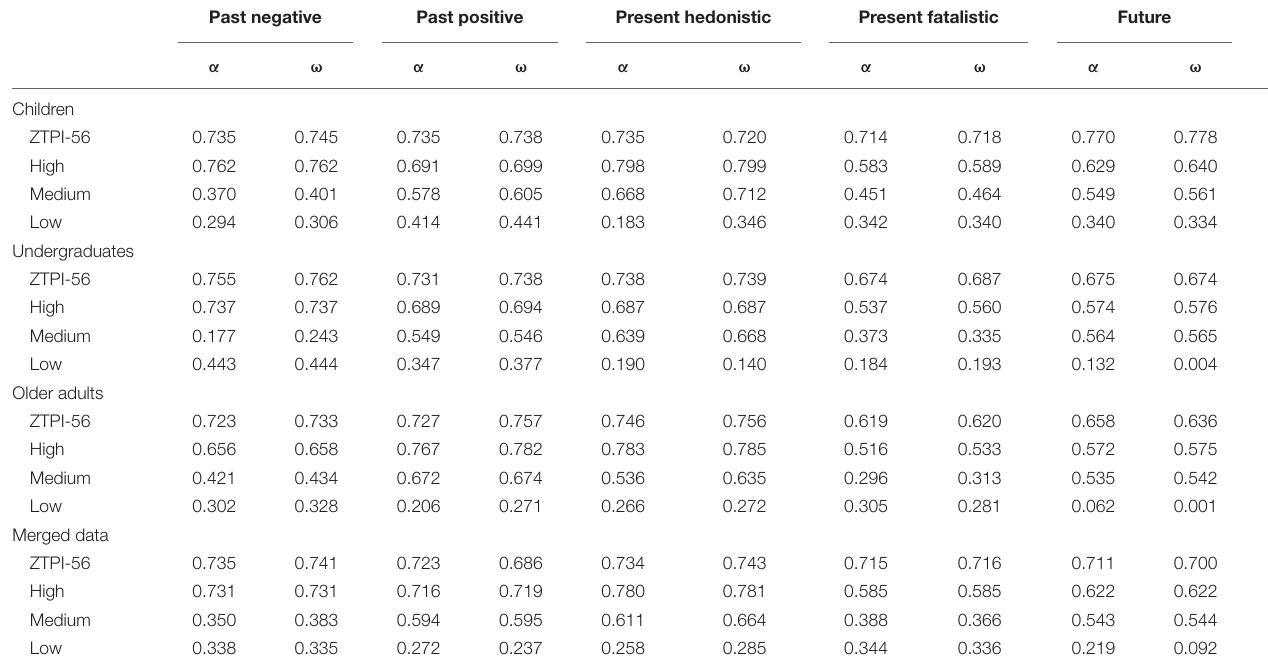
TABLE 3 | Cronbach’s α and ω estimates for ZTPI-56 and three short forms with high, medium, and low frequent